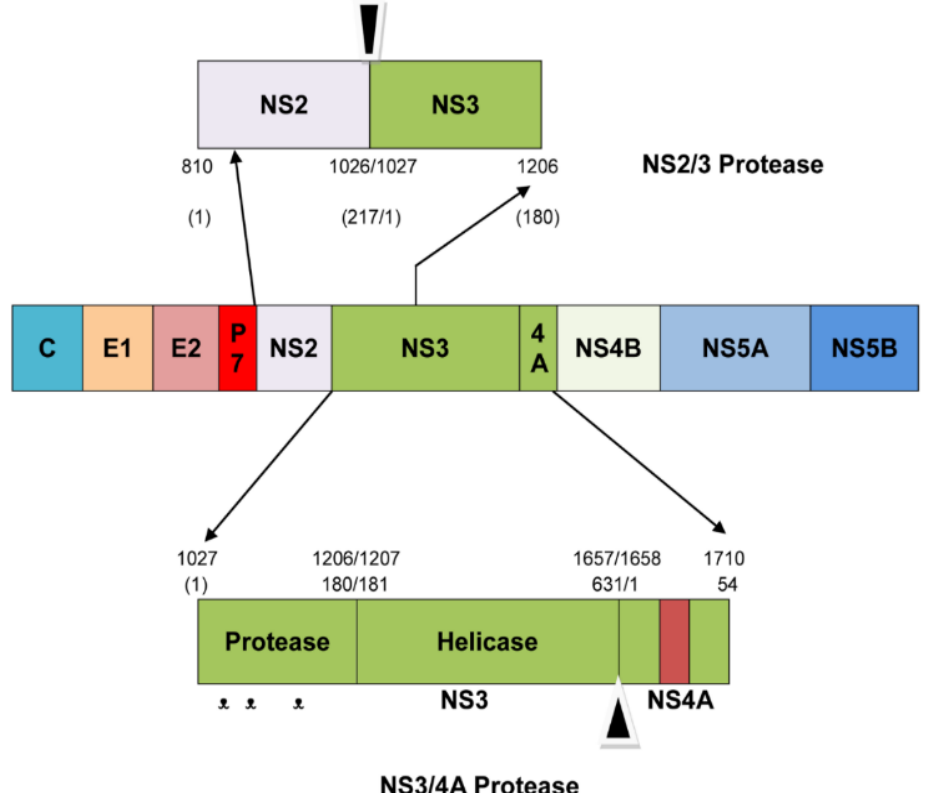
Figure 1. Schematic representation of the HCV NS3/4A protease. The amino acid position for the domain and sub-domain is indicated as a number either starting from the 1st amino acid of the entire polyprotein (the number at the top) or starting from the 1st amino acid of the NS3 or NS4A (the number at the bottom). On the NS3/4A protease, the catalytic triad, namely His-1083, Asp-1107 and Ser-1165 of the polyproteins (or His-57, Asp-81, and Ser-139 of the NS3), is indicated as “ ᵜ ”. The reddish box in the NS4A indicates the 14-amino acid central hydrophobic region of NS4A (amino acids 1678–1691 of the polyprotein or amino acids 21–34 of the NS4A), which has been shown to be sufficient for activation of the NS3 protease activity.